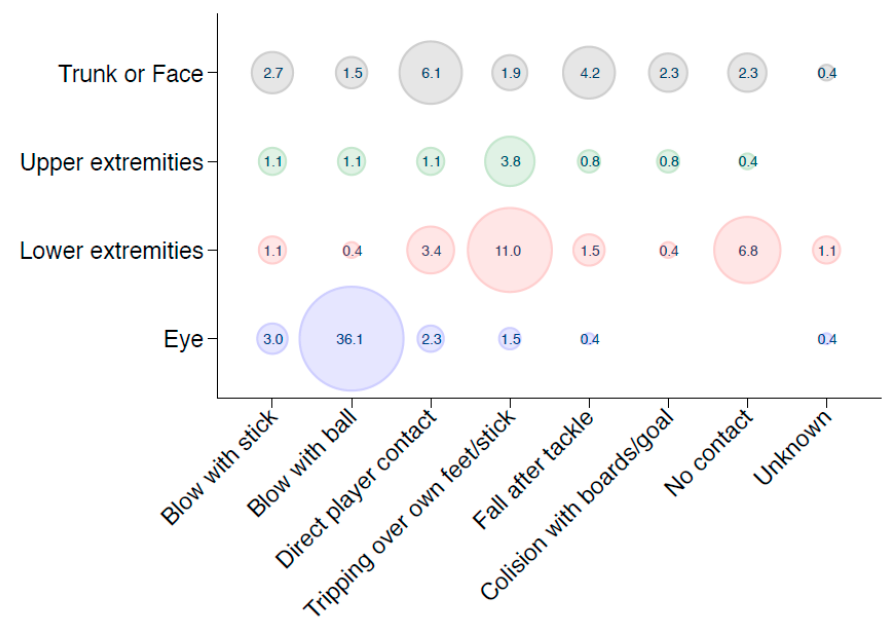
Figure 3. Bubble chart of the mechanism of injuries related to four main injured body regions. In the middle of the bubbles are shown the percentages of all 263 injuries.